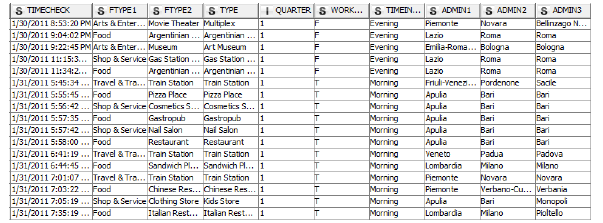
Figure 4. A sample part of input data.